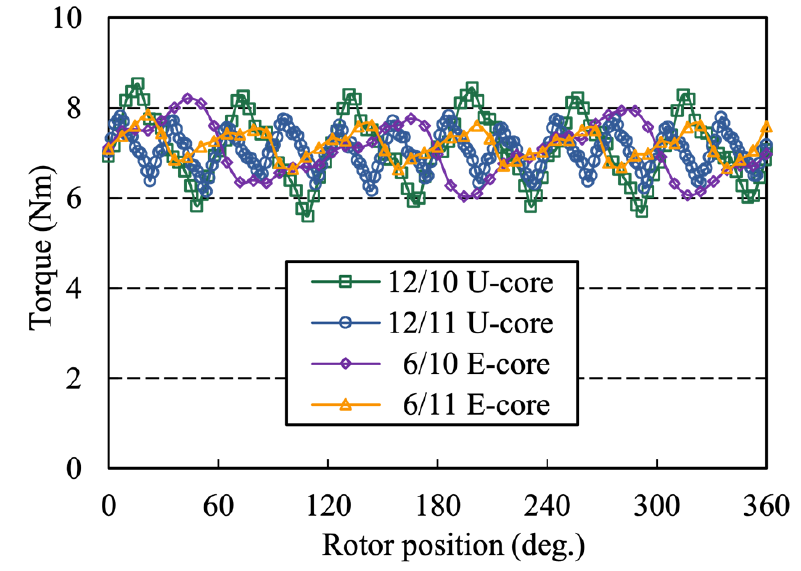
Figure 8. Electromagnetic torque of the four candidates.